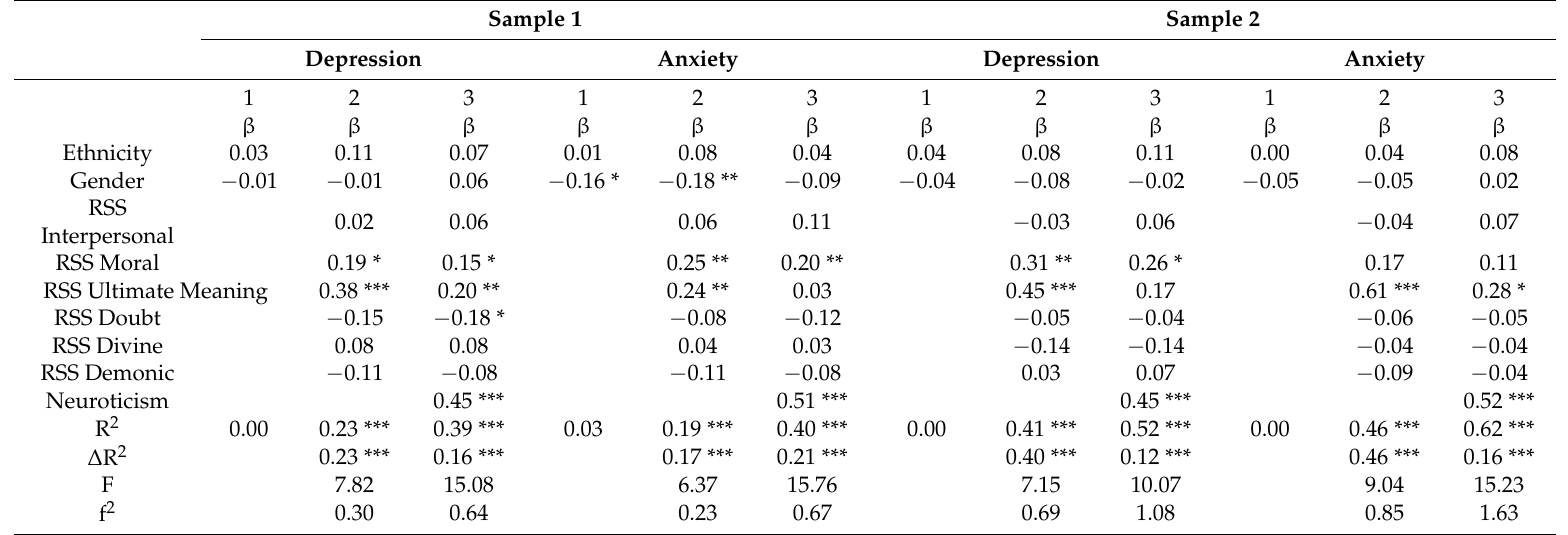
Table 5. Hierarchical Multiple Regressions Predicting Distress from R/S Struggles among